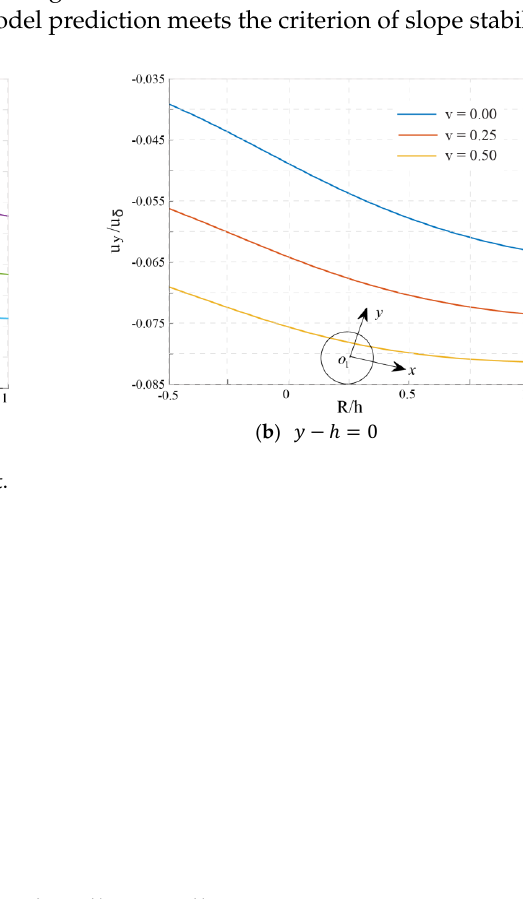
Figure 14. Approximate solution on the slope for 𝑅/ℎ =0.5, 𝑥/ℎ = 0 𝑣 = 0.50 , −0 .09 𝑢 𝑥 0.09.